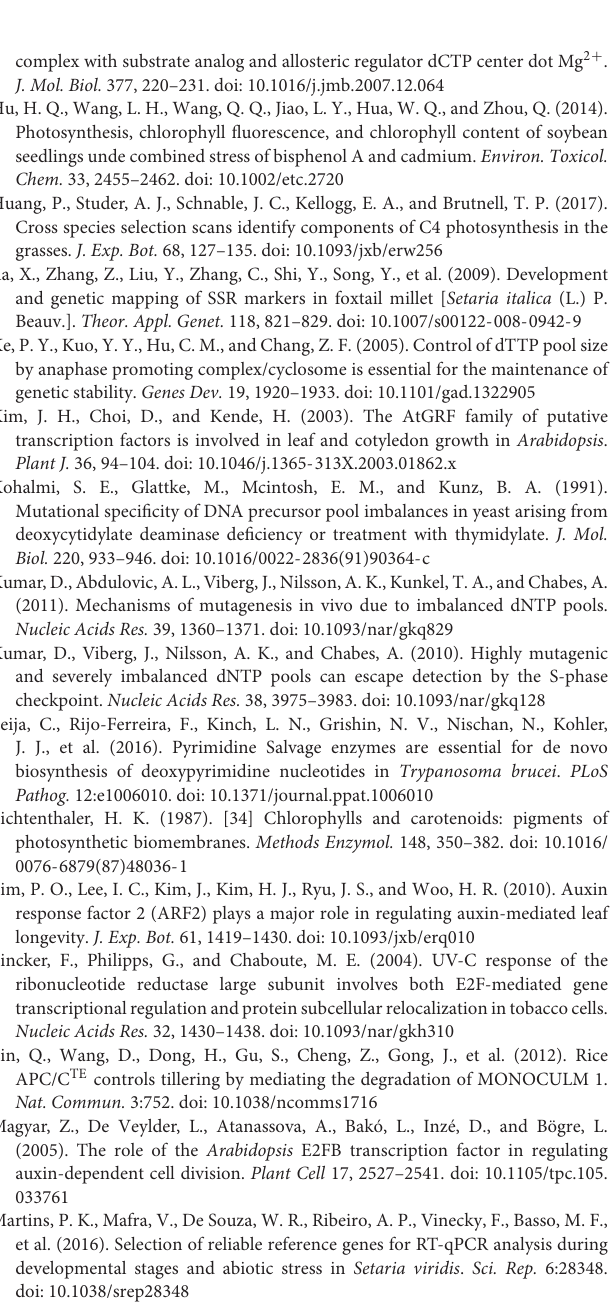
TABLE S1 | SSR and In-Del markers for fine mapping. TABLE S2 | Primers used for qRT-PCR. TABLE S3 | Primers used for yeast one-hybrid. TABLE S4 | Characterization of agronomic traits of sistl2 mutant. TABLE S5 | Putative mutation sites information. TABLE S6 | Genes that were differentially expressed in sistl2 compared with the wild-type. TABLE S7 | DEGs in mutant phenotype-associated pathways.